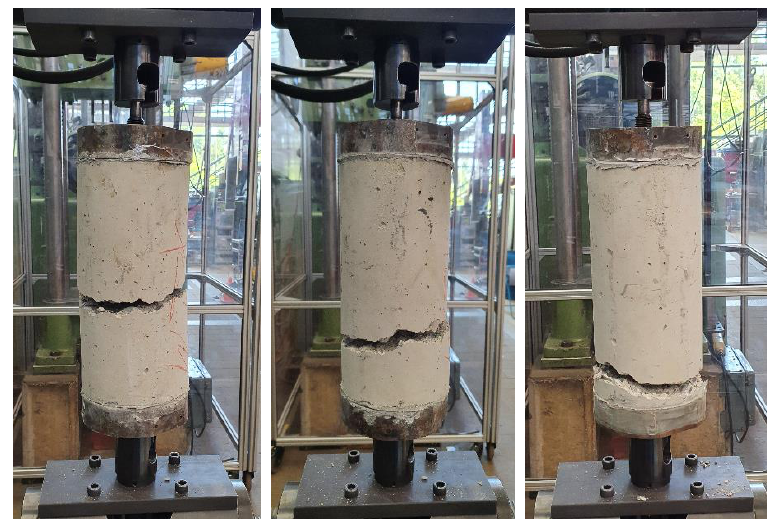
Figure 4. Direct tensile tests (cylinder Ø 150 × 300 mm, C30/37, d g = 16 mm).